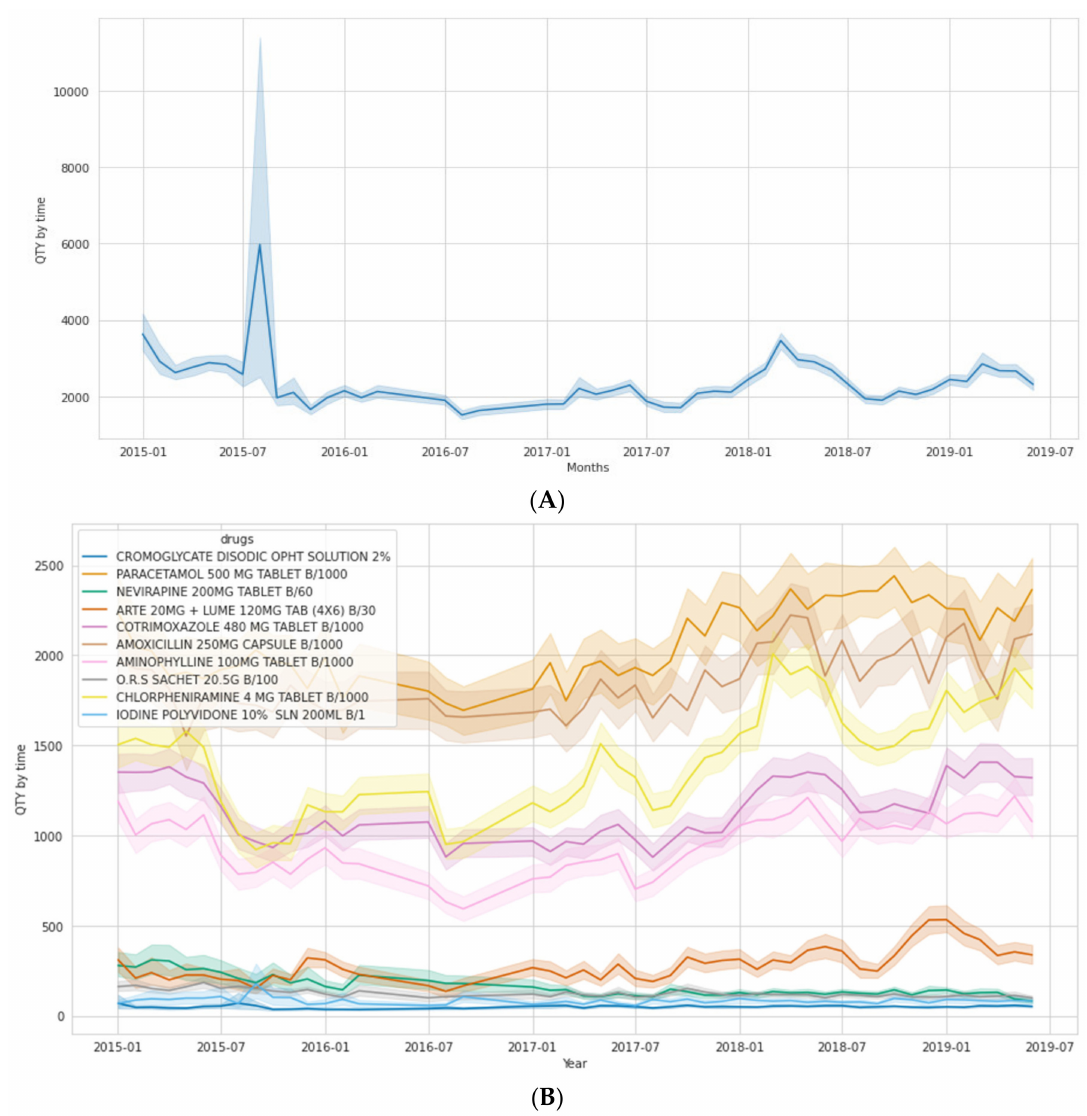
Figure 1. ( A ): Quantity of consumed drugs by the time (all selected essential medicines combined). ( B ): Quantity of Consumed drugs by the time (Selected essential medicines